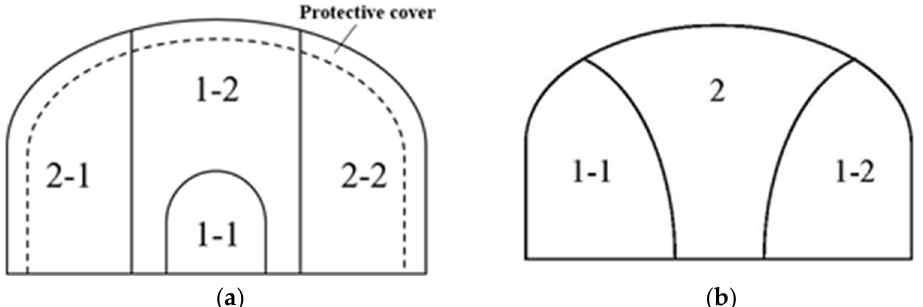
Figure 9. Excavation procedures of the top arch zone. ( a ) Middle-drift connection followed by sides excavation (MDBS/MDBS(P)). ( b ) Both sides heading followed by middle pier excavation (BSMP).